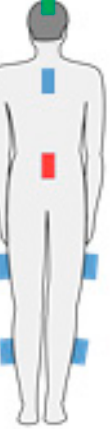
Figure 2. Placement of devices (coloured rectangles) on the body, various configurations: one-device—red; six-device—red and blue; seven-device—red, blue, and green.